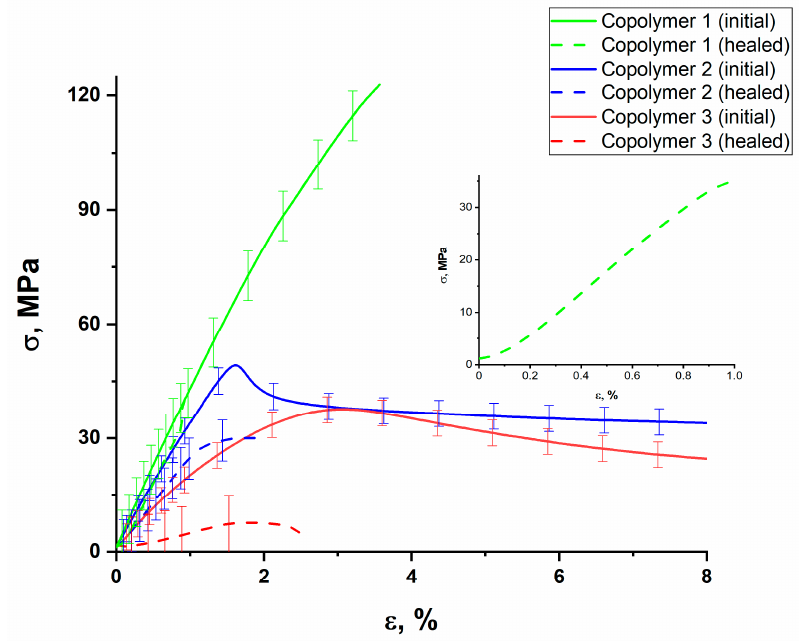
Figure 6. ( a ) Spade specimens for tensile machine studies; ( b ) optical microscopic images of healing for the original and healed samples are shown in Figure 7. of specimens with the addition of 0.1 M HCl to study the physical and mechanical properties.